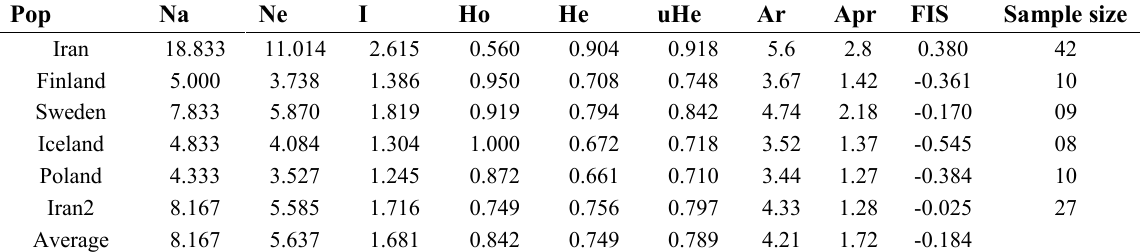
Table 2. Genetic variability within six Whooper Swan populations based on SSR markers.